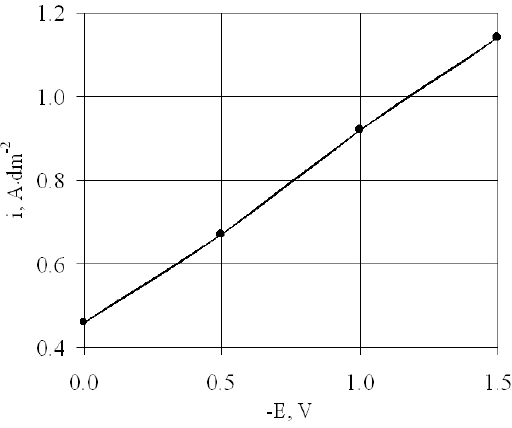
Figure 3. Dependency of current density vs. cathode potential of ITO-glass in acetonitrile solution of 0.01 M AgNO pulse electrolysis under τ